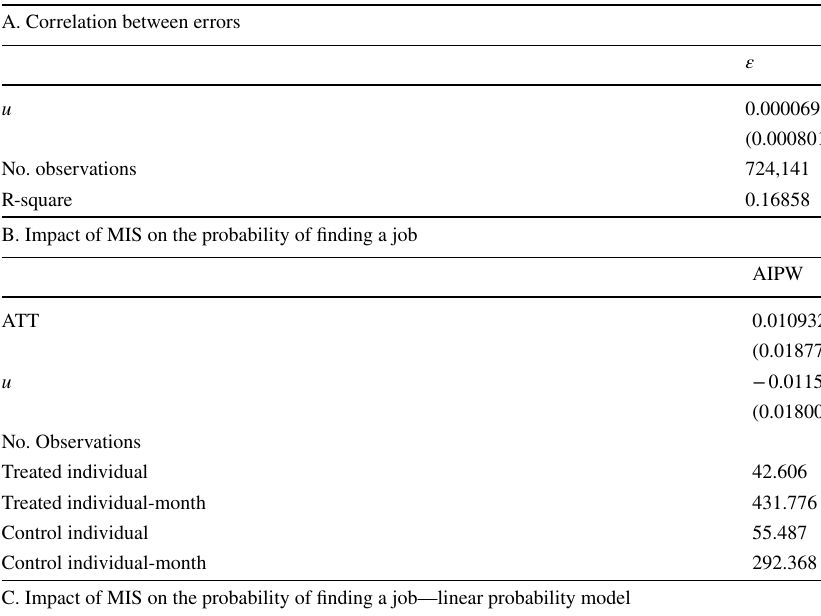
Table 5 Robustness check: impact of MIS on the probability of finding a